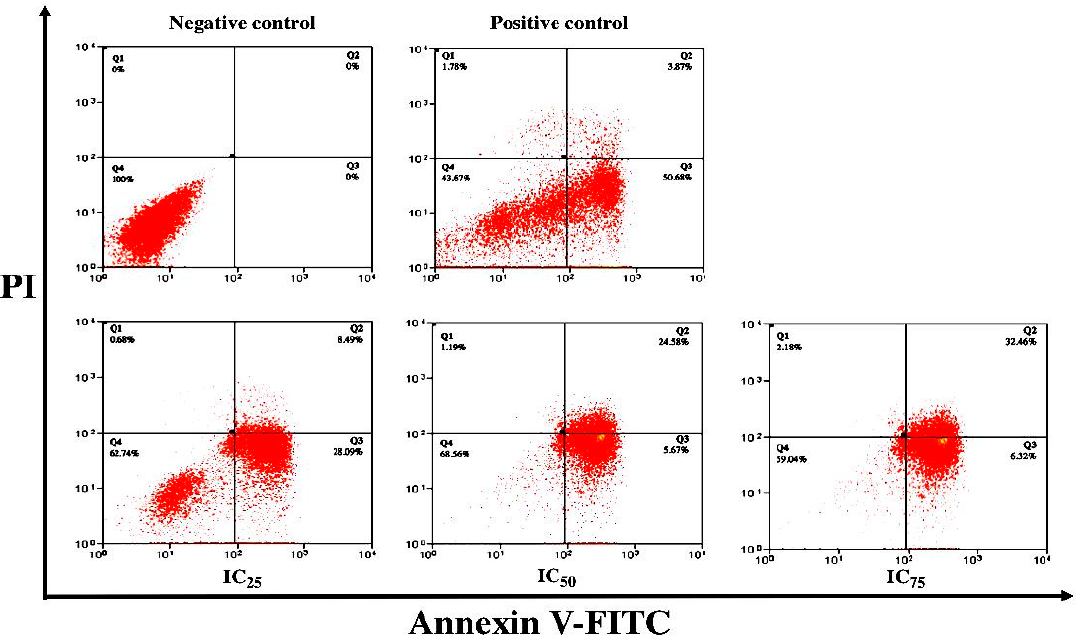
Figure A2. The percentage of viable, early apoptotic, late apoptotic/early necrotic, and late necrotic cells of negative control (untreated), positive control (tamoxifen) and MCF-7 treated cells for 24 h as determined by a flow cytometer instrument.